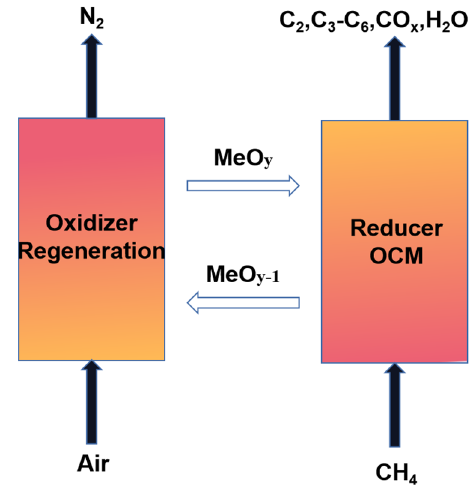
Figure 1. CL-OCM